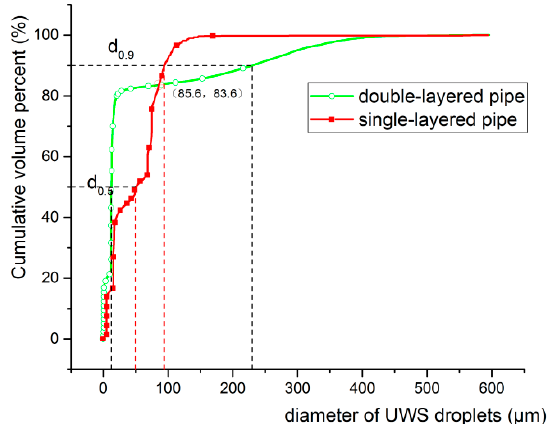
Figure 10. Cumulative volume percentage of UWS droplets.